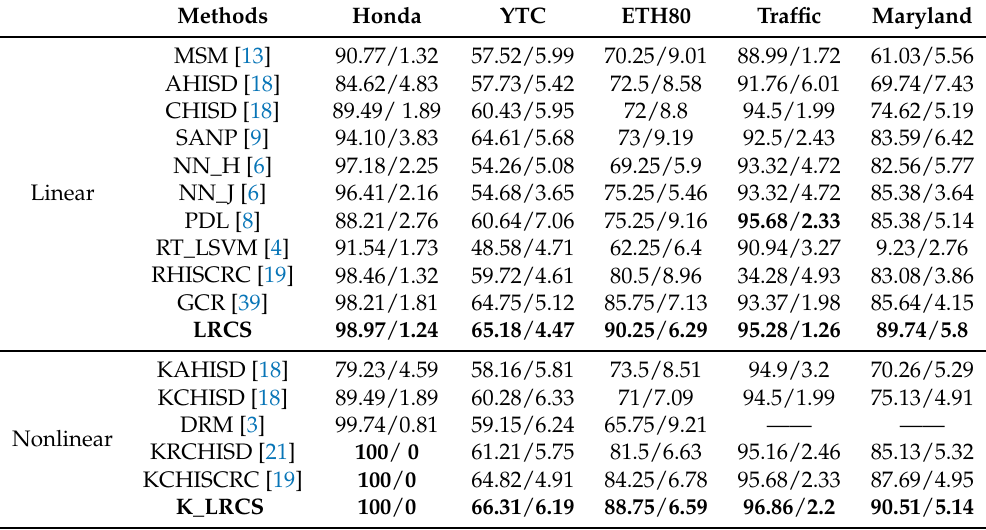
Table 5. Average recognition rates and standard deviations (%) of various methods on the five datasets.